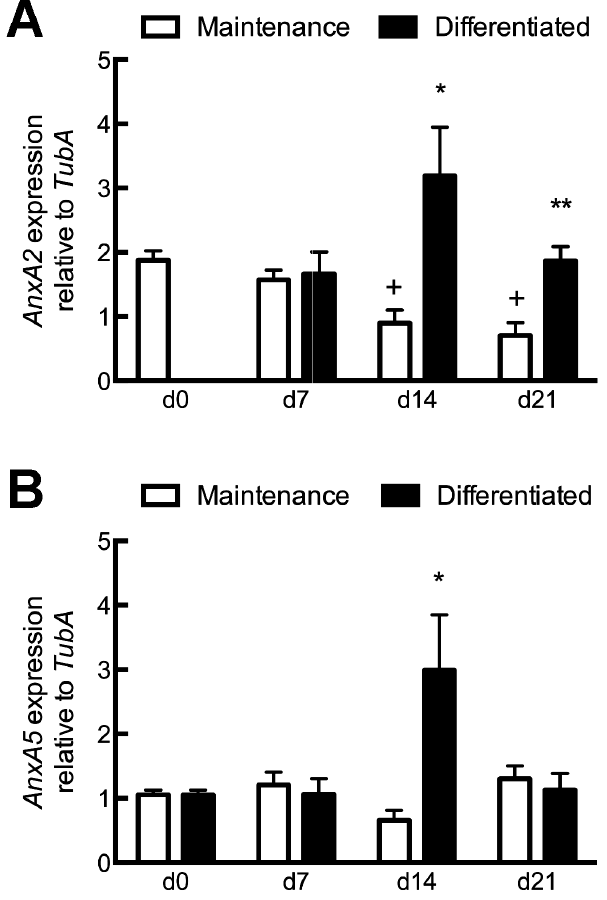
Figure 5. Effects of osteogenic differentiation on expression of AnxA2 and AnxA5. qPCR analysis of (A) AnxA2 or (B) AnxA5 expression in undifferentiated Si cells at day 0 and in cells cultured in maintenance or osteogenic media 7, 14 and 21 days. Each bar represents mean transcript normalized to a -tubulin 6 SEM, n=3–5. *, **represent statistically significant difference from maintenance control at same time point, *p , 0.05, **p , 0.01; + represents statistically different from same media composition on day 0, p , 0.05.